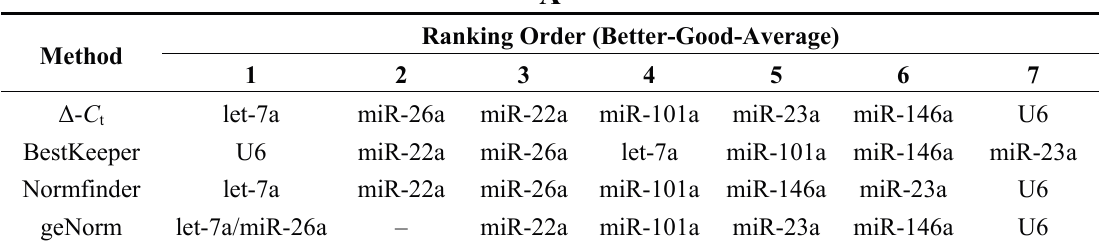
Table 3. Ranking of candidate reference miRNAs and U6 in different adult